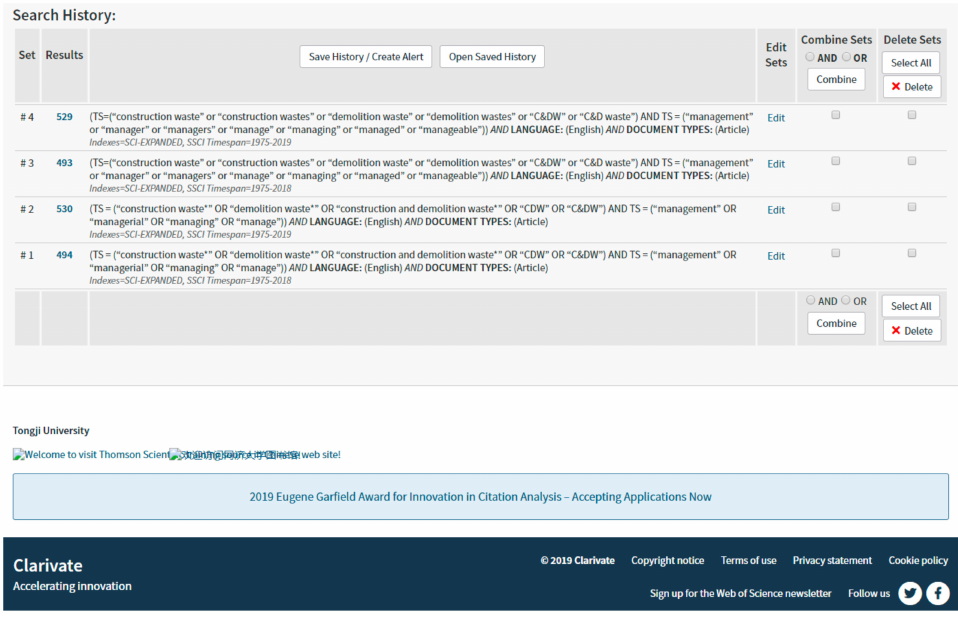
Figure 1. Results of di ff erent search filters in Web of Science